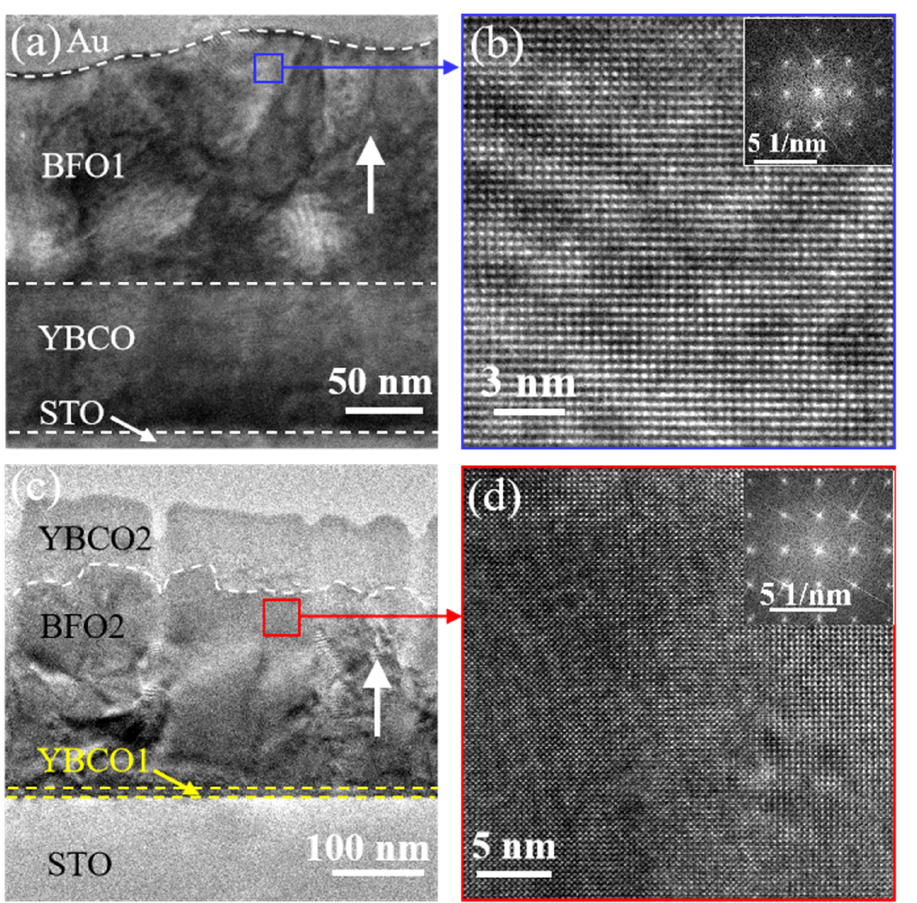
Figure 3. Cross section TEM images of the YBCO2/BFO2/YBCO1 capacitor ( a ) and the Au/BFO1/YBCO capacitor ( c ). The white upward arrows in ( a , c ) indicate the direction of growth. High resolution TEM images of the BFO films taken in the [110] crystallographic direction of BFO1 ( b ) and BFO2 ( d ). Figure 2b taken from